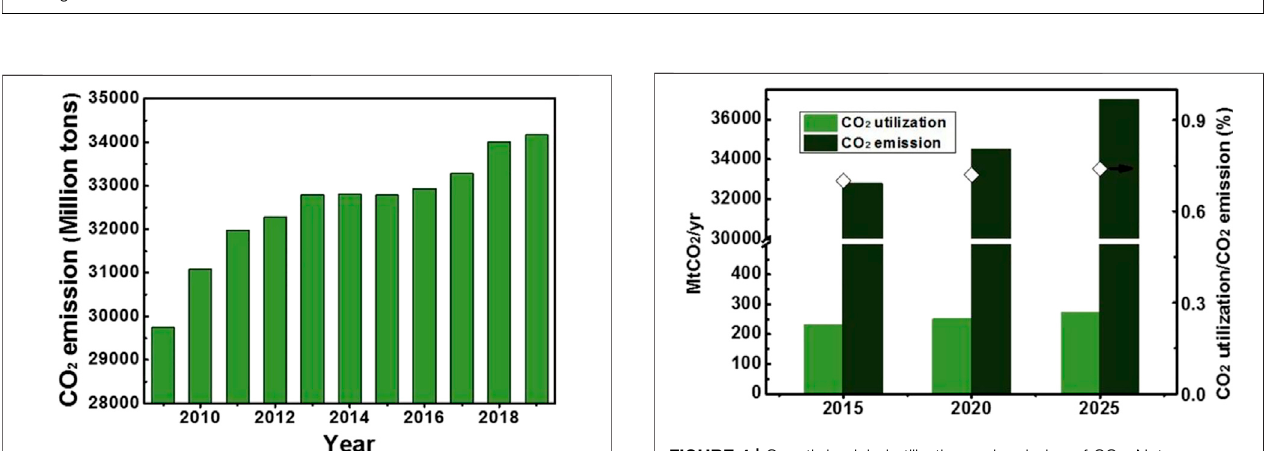
FIGURE 4 | Growth in global utilization and emission of CO 2 . Note: Projections for future global CO 2 demand are based on an average